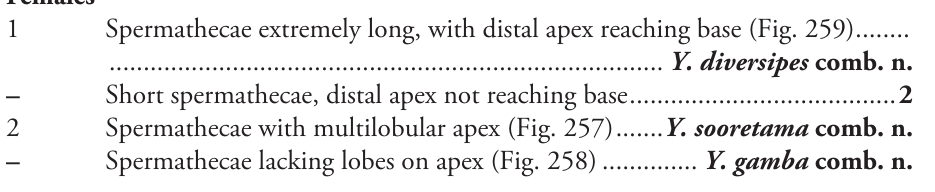
Female: Spermathecae (Fig. 257): two completely separated, not-twisted, long spermathecae, with multilobular apex and accentuated outwards curvature medially. Spermatheca midwidth as wide as its base width, virtually